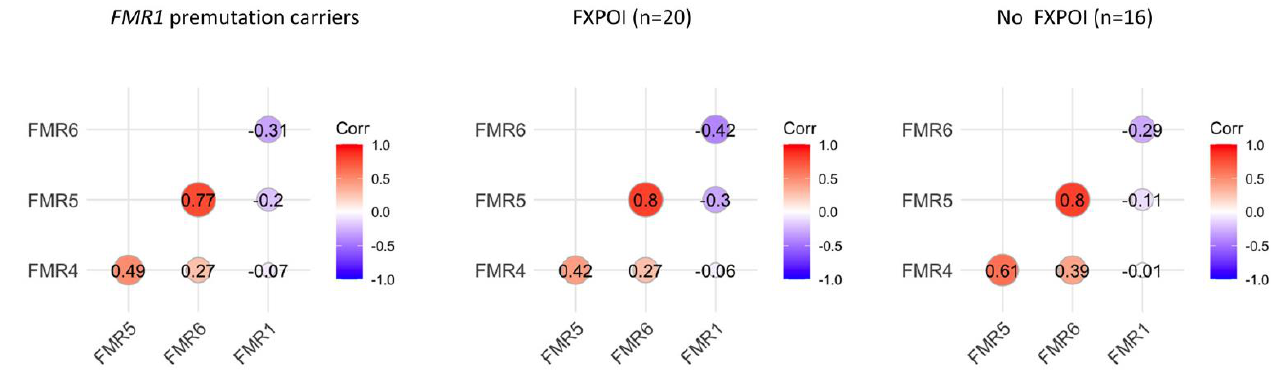
Figure 2. Correlation between expression levels of FMR4, FMR5 and FMR6 was evaluated among total FMR1 premutation carriers as well as groups of women with FXPOI and without FXPOI.